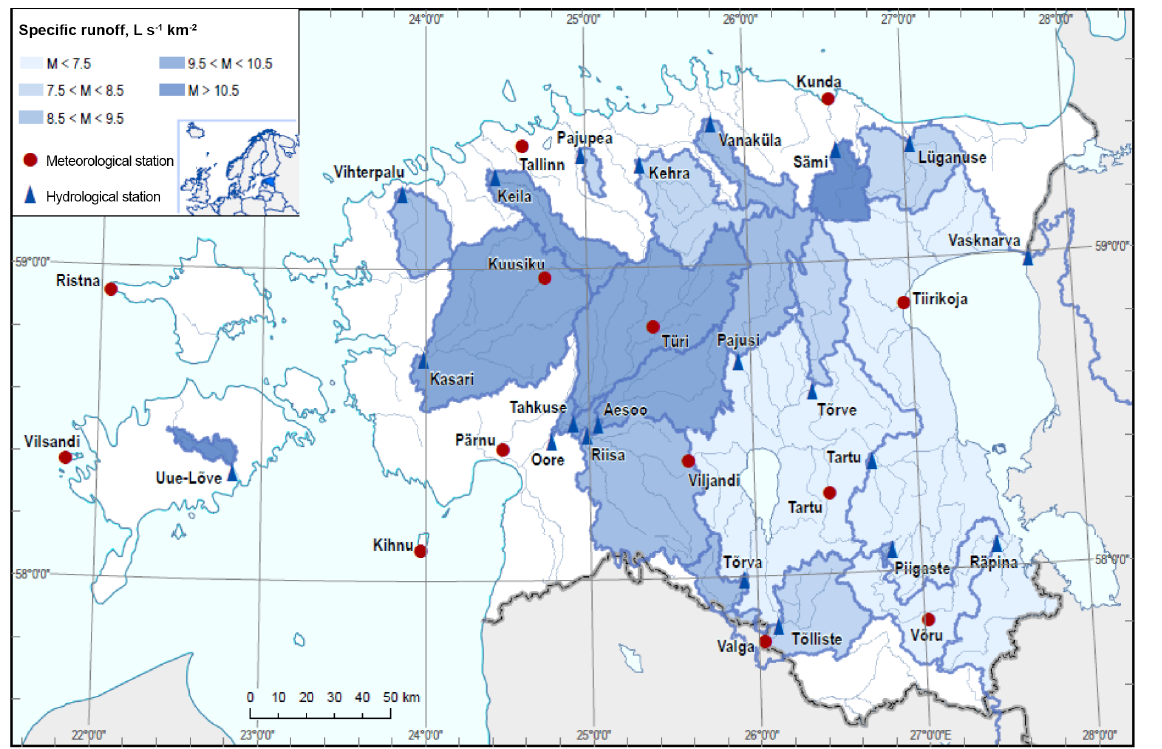
Figure 1. Location map of Estonia with meteorological and hydrological stations, as well as annual mean specific runoff of studied river